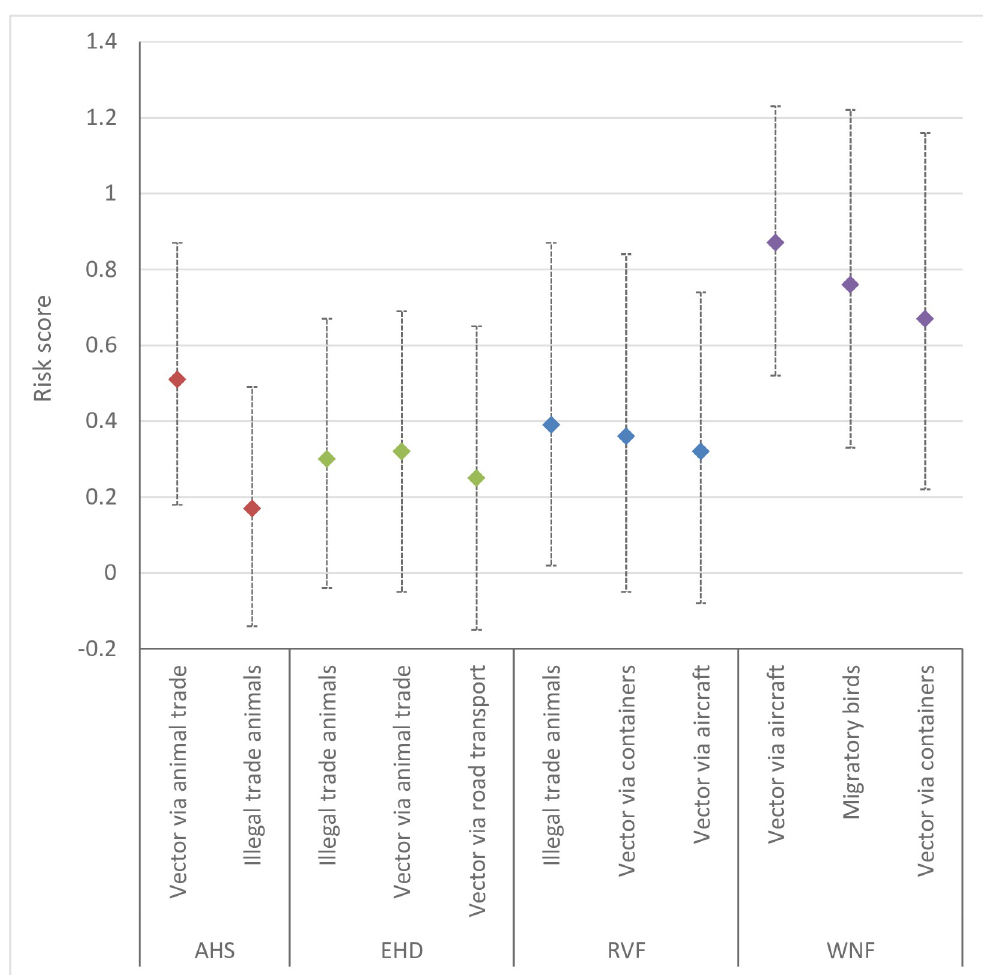
Fig 3. Risk scores (median values) and their uncertainty (95% uncertainty interval) for the rate of introduction of four vector-borne diseases for the Netherlands via selected pathways. AHS = African horse sickness; EHD = epizootic haemorrhagic disease; RVF = Rift Valley fever; WNF = West Nile fever.